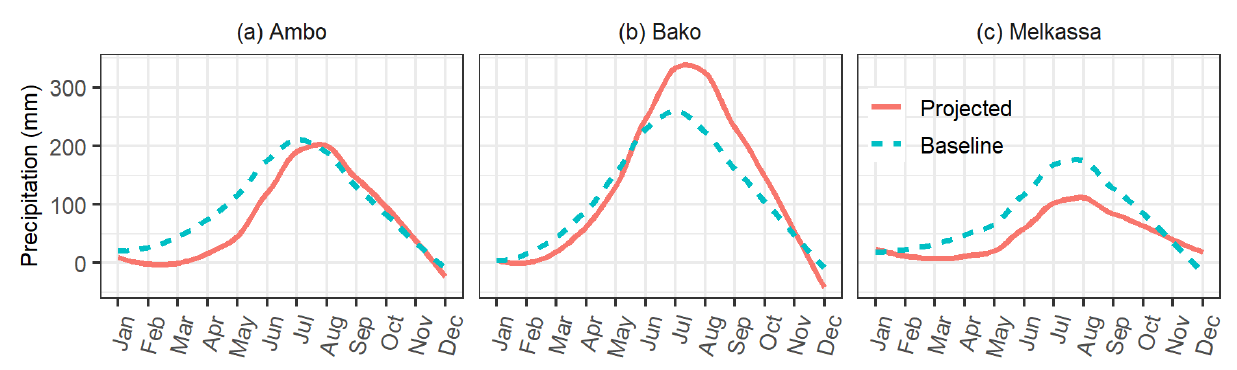
Figure 1. Total monthly precipitation amount projected by the multimodel ensemble for 2030 compared to that observed (1995–2017) period for ( a ) Ambo (high altitude), ( b ) Bako (mid-altitude), and ( c ) Melkassa (low altitude).